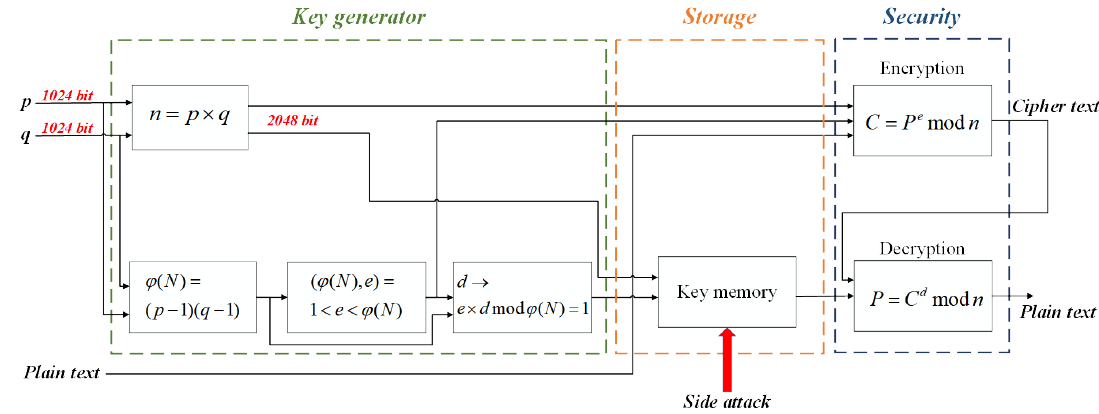
Figure 3. Conventional RSA block